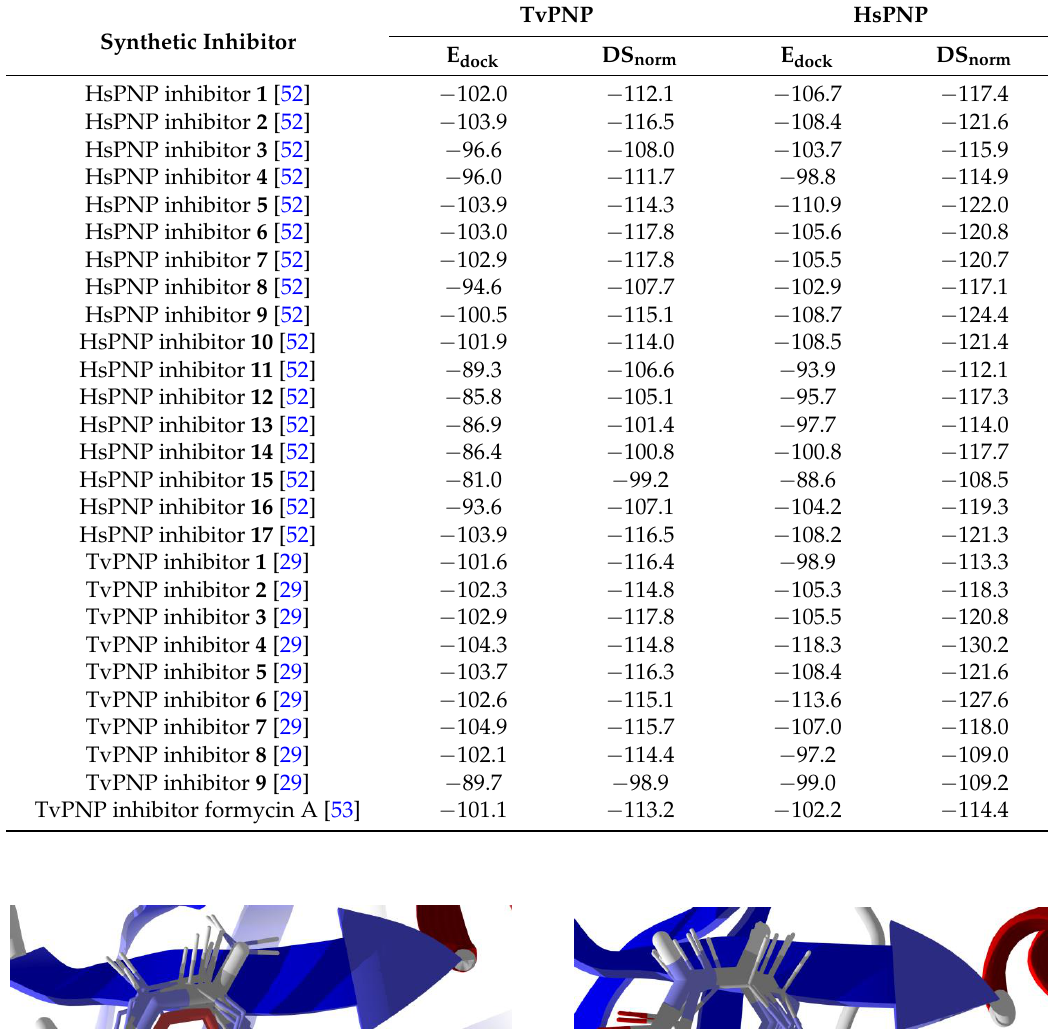
Table 2. MolDock (re-rank) docking scores (E dock ) and normalized docking scores (DS norm ) (kJ/mol) for